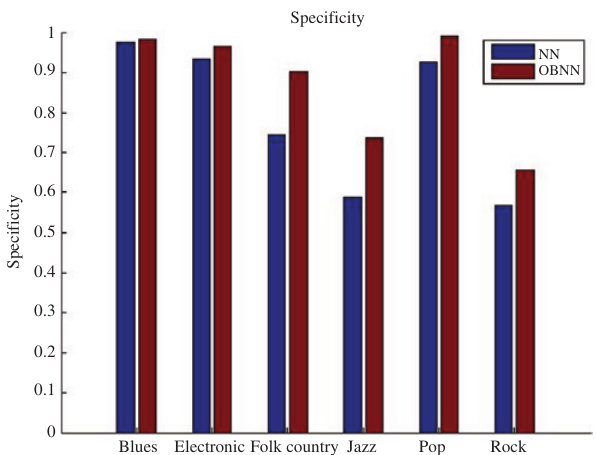
Figure 4: Specificity Comparisons of the Proposed and Existing